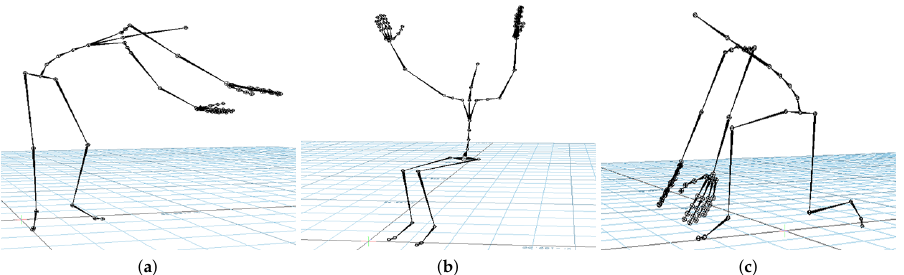
Figure 5. Gesture vocabulary with motion primitives based on EAWS (G 4 ). ( a ) G 4,1 : Standing while bending forward and rotating the torso; ( b ) G 4,2 : Sitting while raising arms above shoulder level; ( c ) G 4,3 : Kneeling while bending